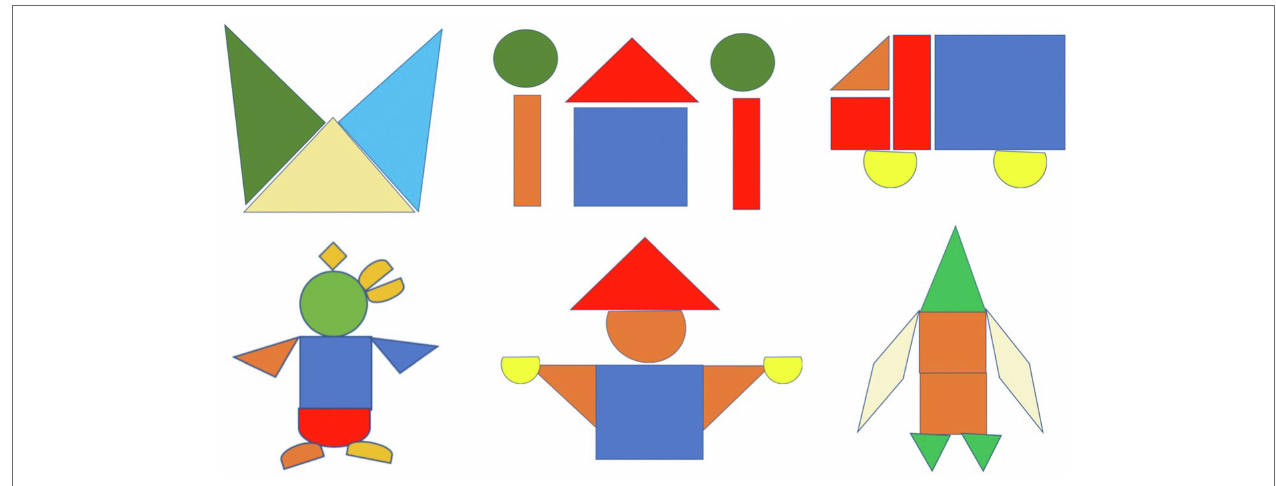
FIGURE 7 | Images completed by children during their training sessions. All children received the cat and penguin images for their first training, the house and person images for their second training, and the truck and rocket images for their third